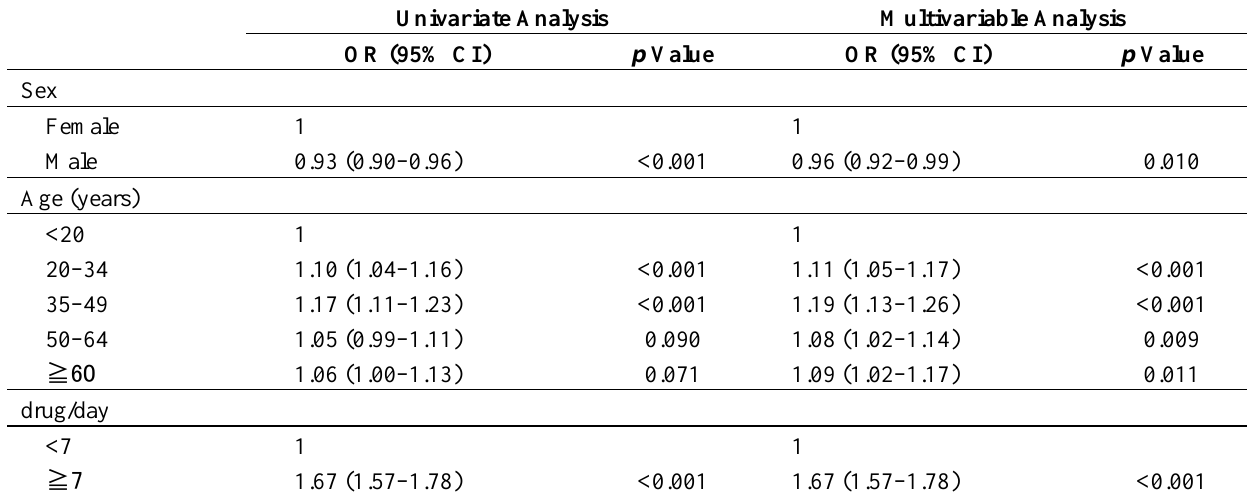
Table 8. Factors associated with the polyherbal prescription (>5 drugs in a single prescription) of Chinese herbal medicine (CHM) in a multivariate logistic